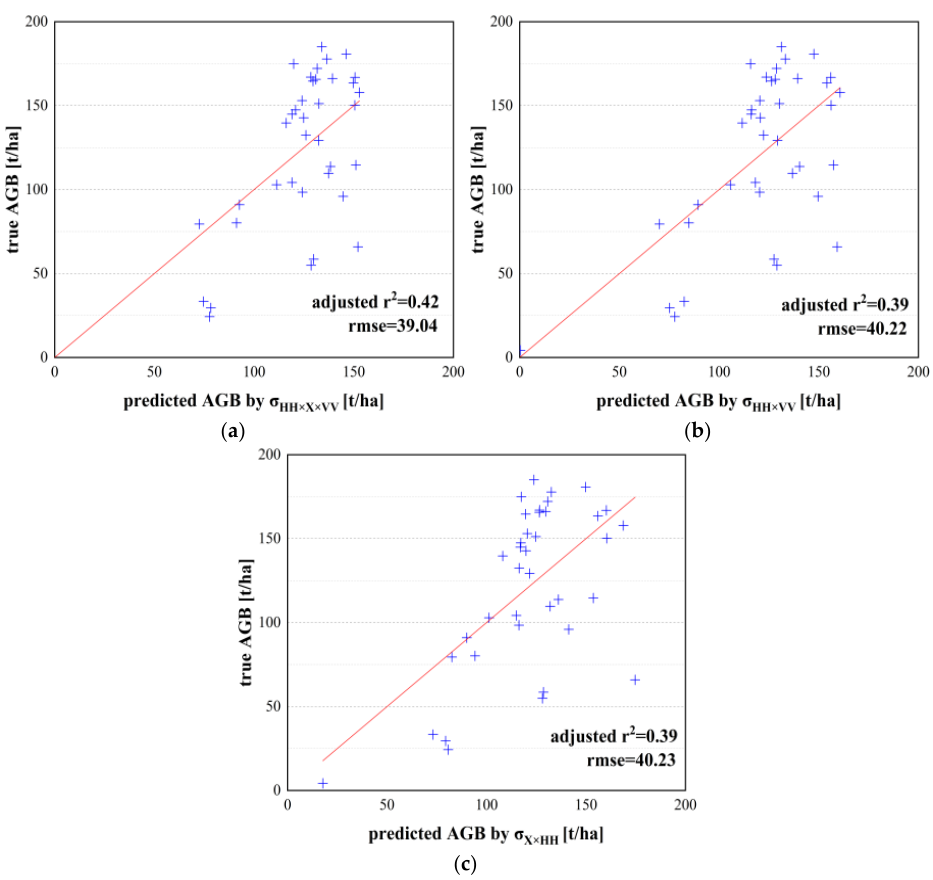
Figure 5. ( a ) Models established by σ HH × X × VV and AGB; ( b ) models established by σ HH × VV and